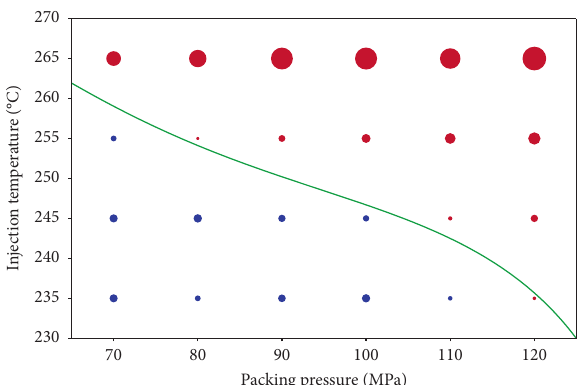
Figure 5: Classification hyperplane (green curve); red dots are overweight samples; blue dots are underweight samples.